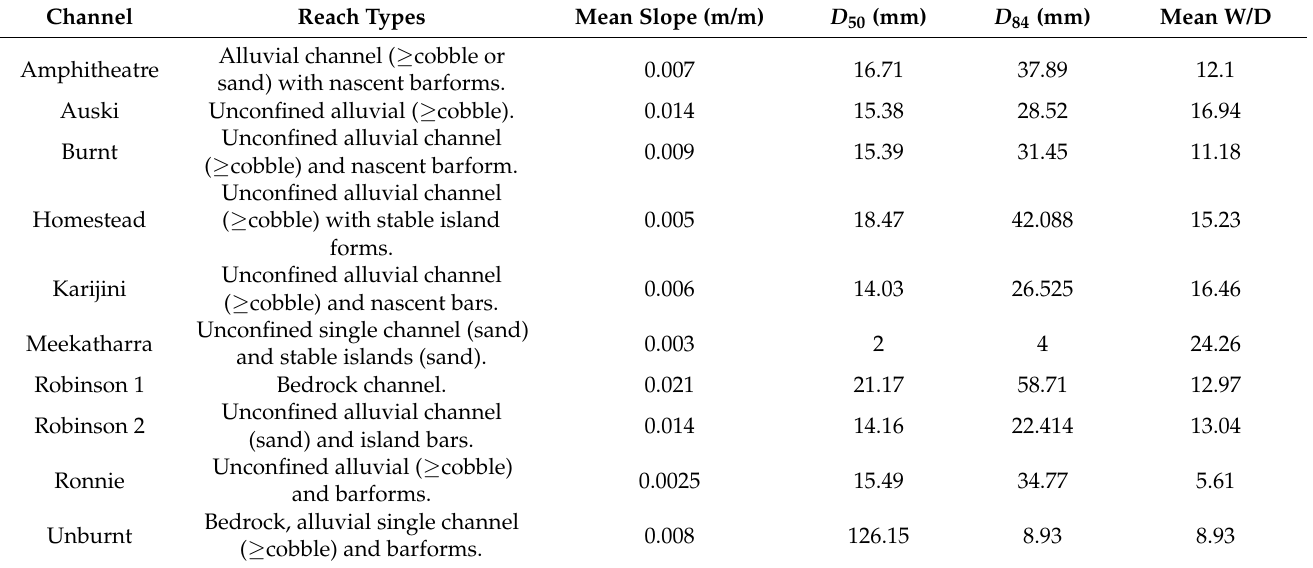
Table 4. River reach characteristics as calculated from SfM-derived point clouds and BASEGRAIN sediment analysis. Mean D 50 and D 84 values from each surveyed channel are